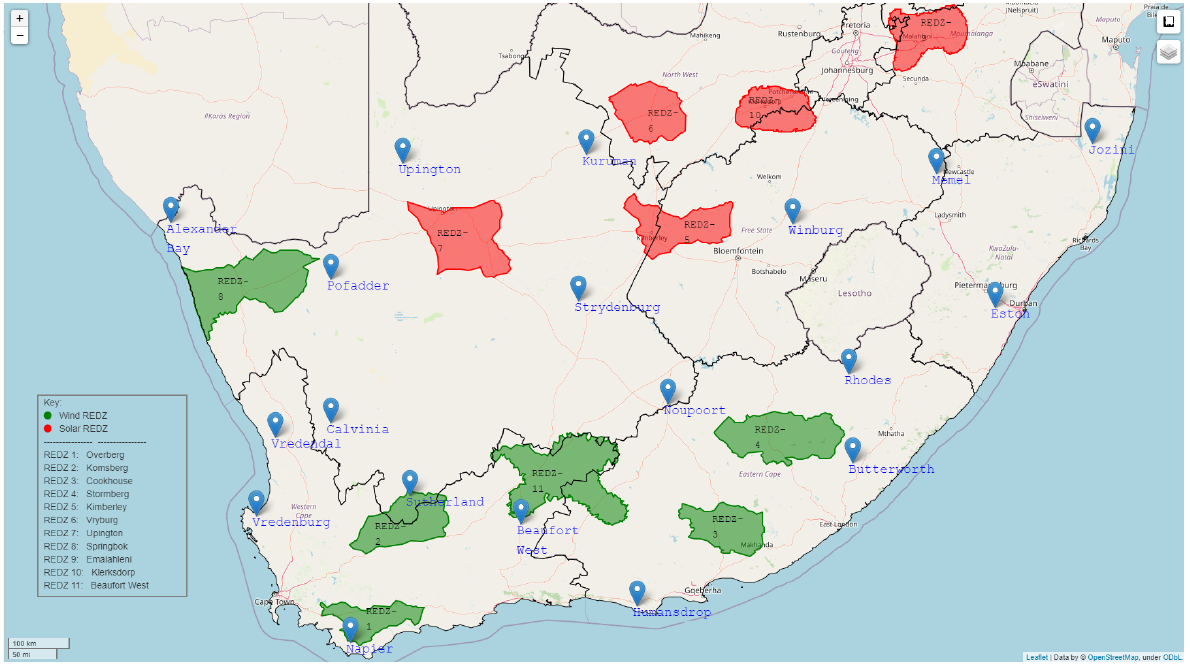
Figure 2. Renewable energy development zones in South Africa.